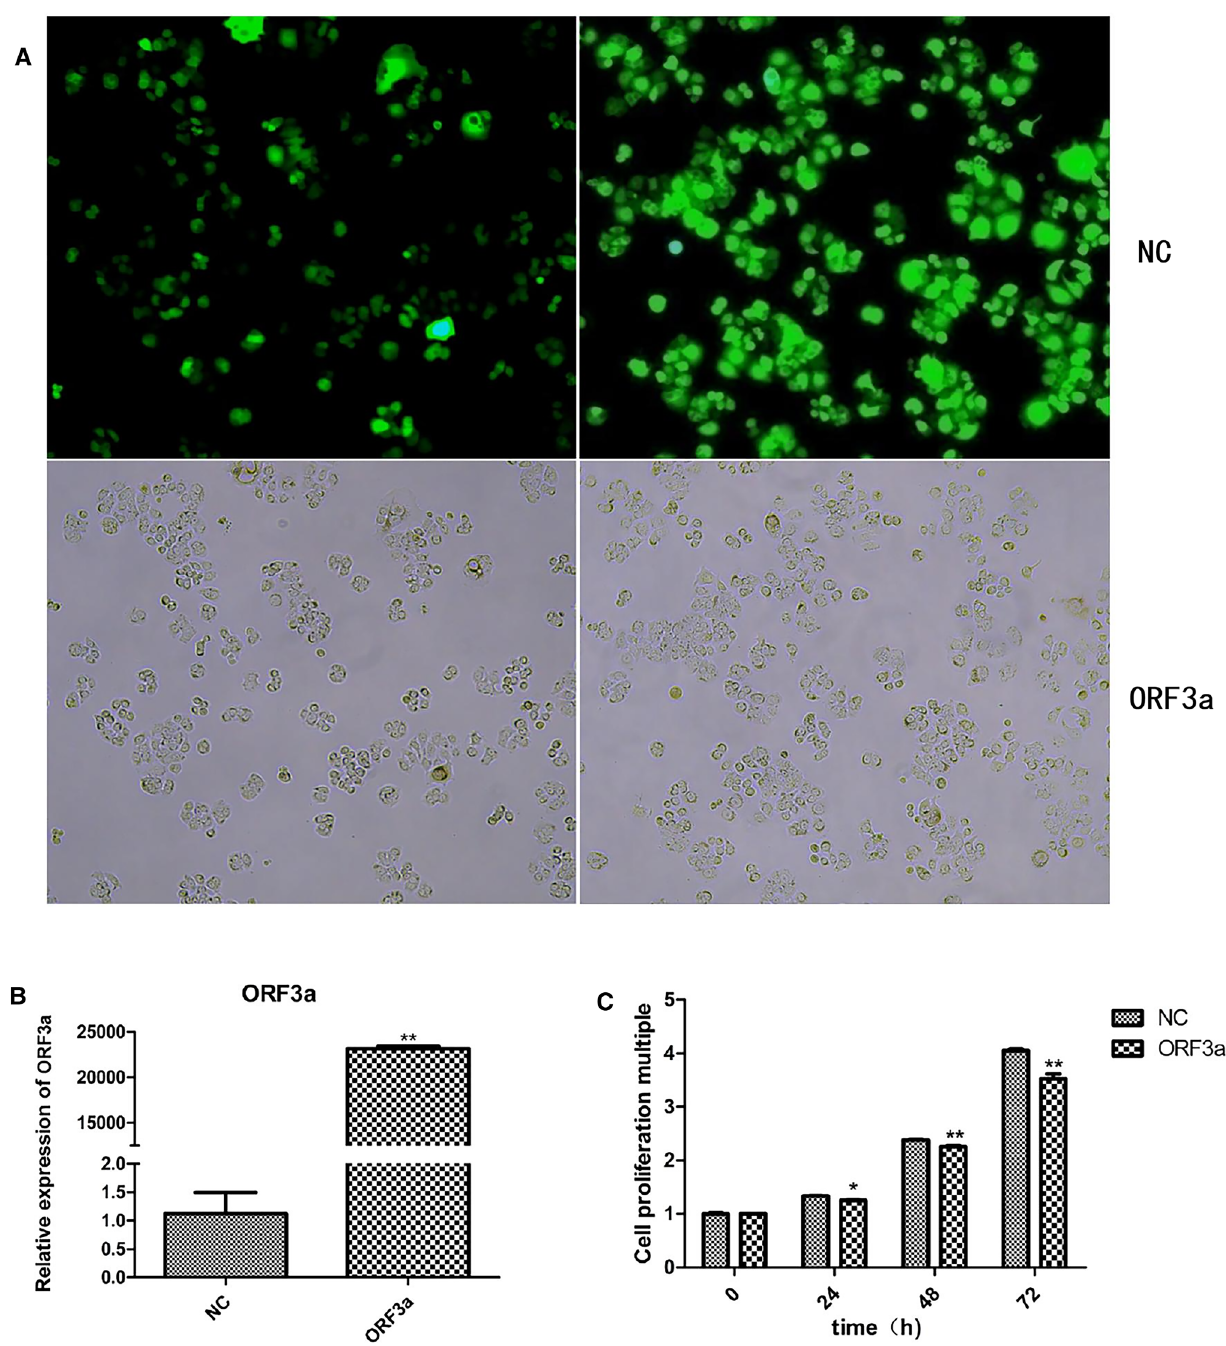
Fig. 1 ORF3a was successfully expressed in SW480 cells. A Screening results for stable strain of the control virus. The control virus was pack- aged with a vector driving expression of GFP, and the overexpressing ORF3a vector did not drive the expression of GFP; hence, there was no fluorescence image. B qPCR results showing overexpression of ORF3a. C CCK8 assay results are presented as the mean ± SD values. Two-way ANOVA was used for statistical analysis; *P < 0.05 and **P < 0.01 were used as the screening criteria for significant differences and very sig- nificant differences,